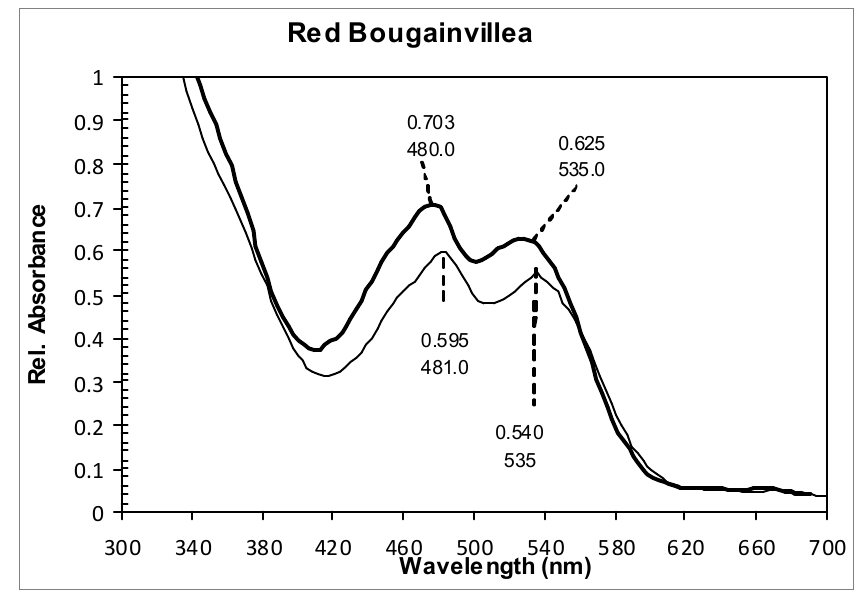
Figure 3. Absorption spectra of red Bougainvillea spectabilis (RBS) extract (thick line) and red Bougainvillea glabra (RBG) extract (thin line), both diluted in water at pH = 5.7. Red